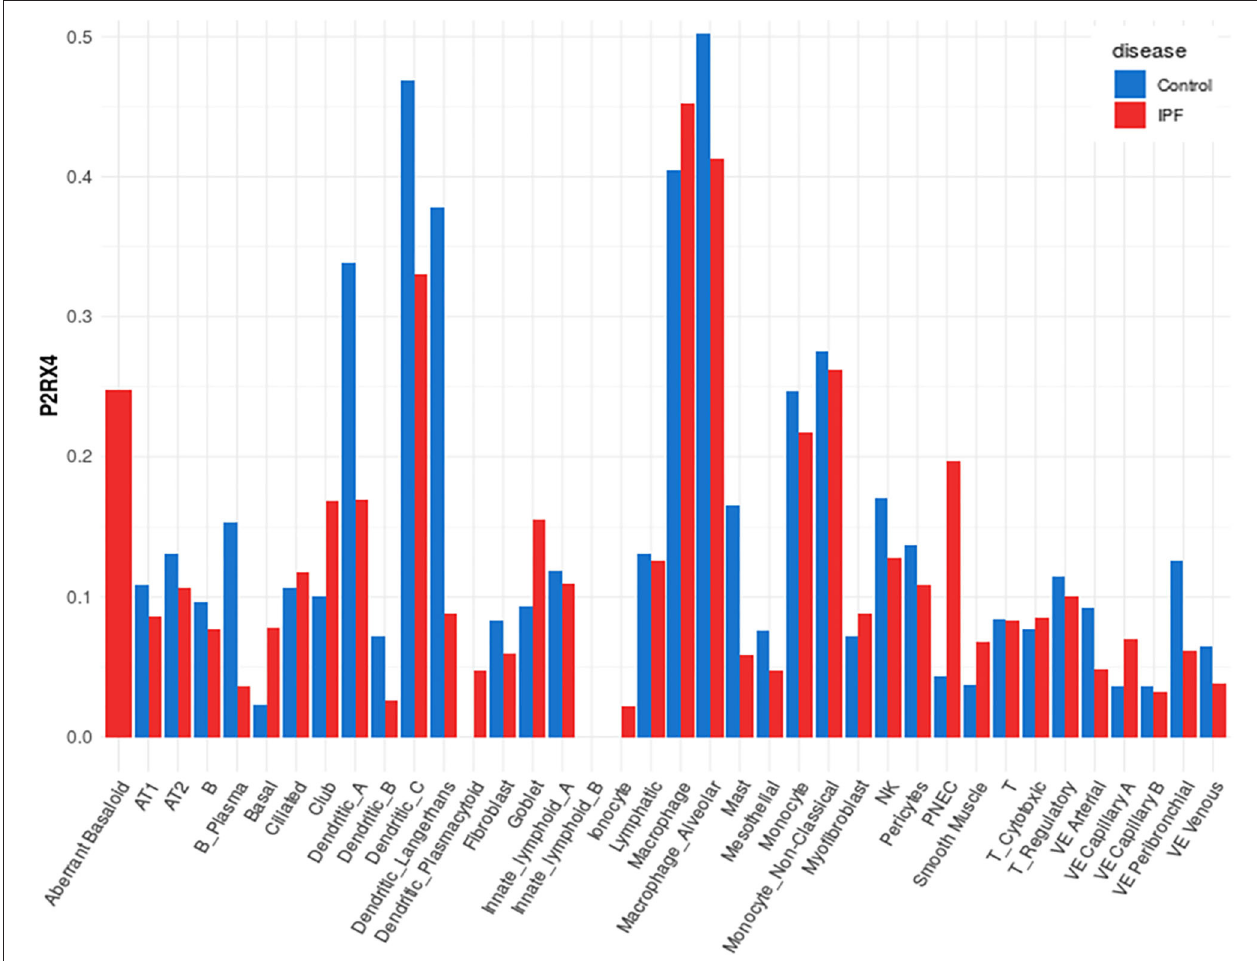
FIGURE 4 | Plot of cell type-specific distribution of P2RX4 expression within healthy and diseased lung tissue. Bar plot showing average P2RX4 gene expression in different cell types of lung tissue, further broken down into disease state, with expression levels from healthy control lung tissue shown in blue bars ( n = 29) and idiopathic pulmonary fibrosis (IPF) lung tissue in red bars ( n = 32). Image is from the “Gene Explorer” tool in the IPF Cell Atlas using the Kaminski/Rosas dataset [https://p2med.shinyapps.io/IPFCellAtlas/, date first accessed: 22/04/2020 ( 30,